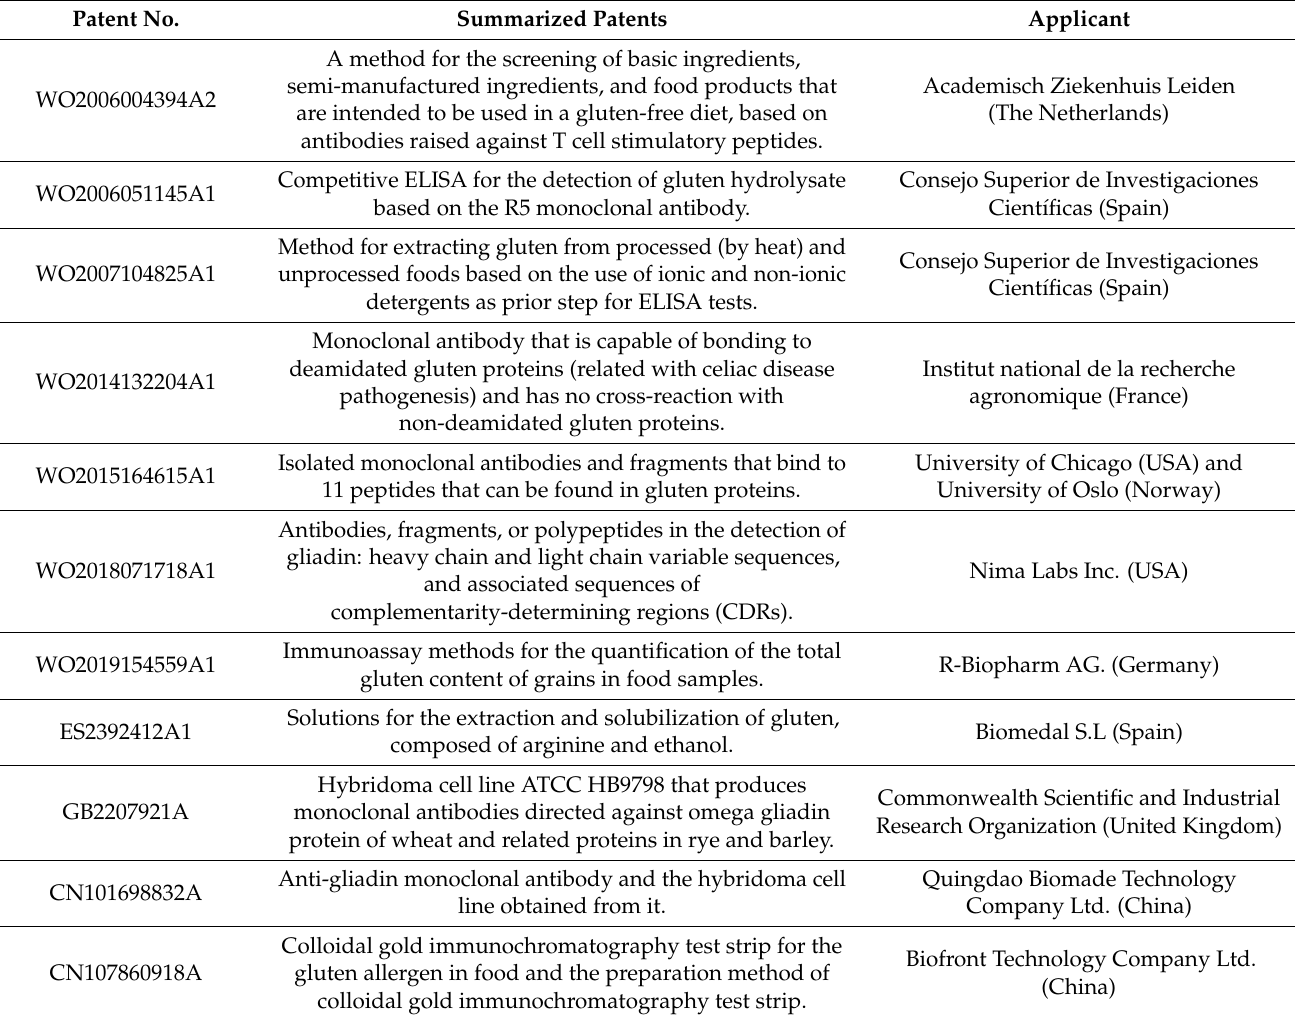
Table 3. Several examples of registered patents claiming monoclonal antibodies and antibody-based methods related to gluten detection. Patent